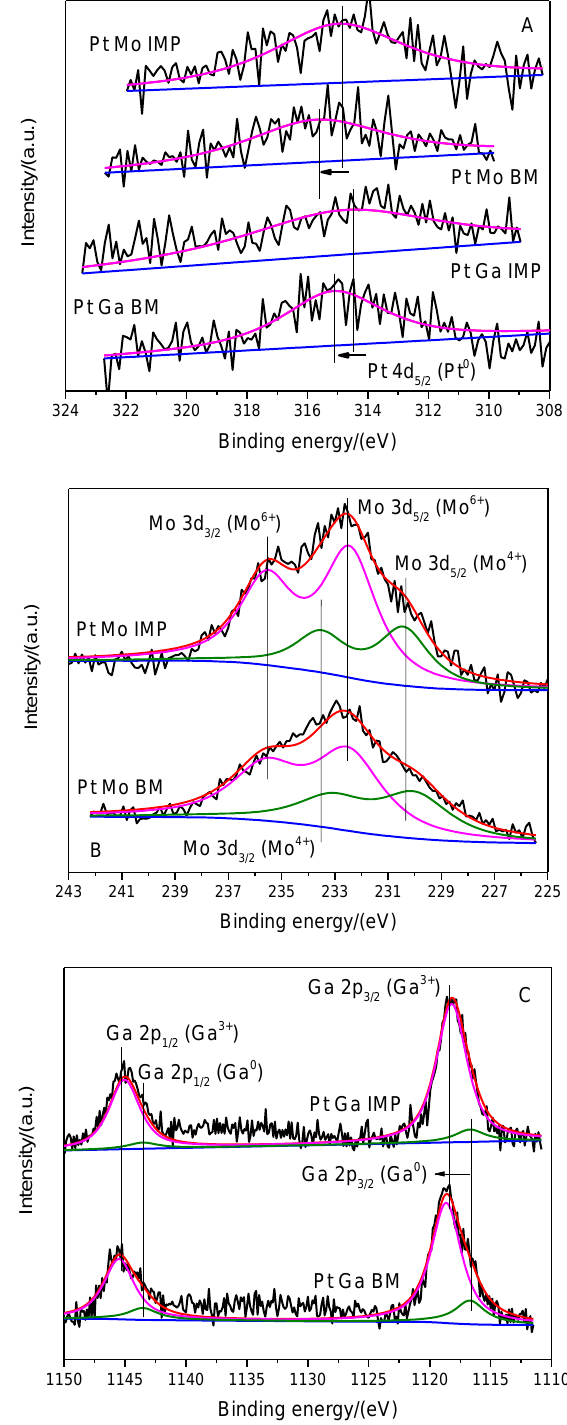
Figure 6. X-ray photoelectron spectrum (XPS) spectra of the Pt 4d ( A ), Mo 3d ( B ), and Ga 2p ( C ) regions for the Pt Mo/Ga samples. All of the samples are reduced at 500 °C.